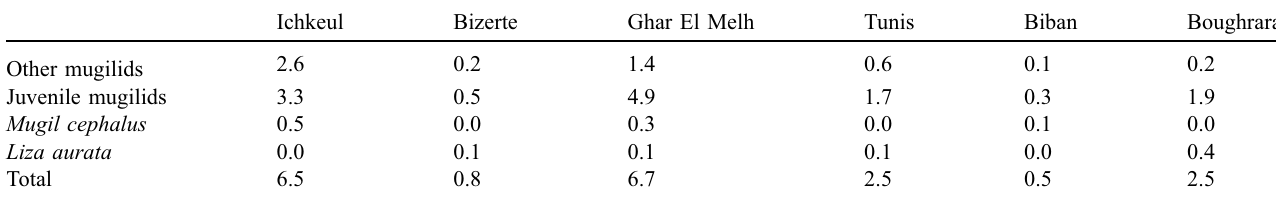
Table 6. Mean yearly harvest (inkg/yr/ha) of mugilids during the period 1995 – 2011.